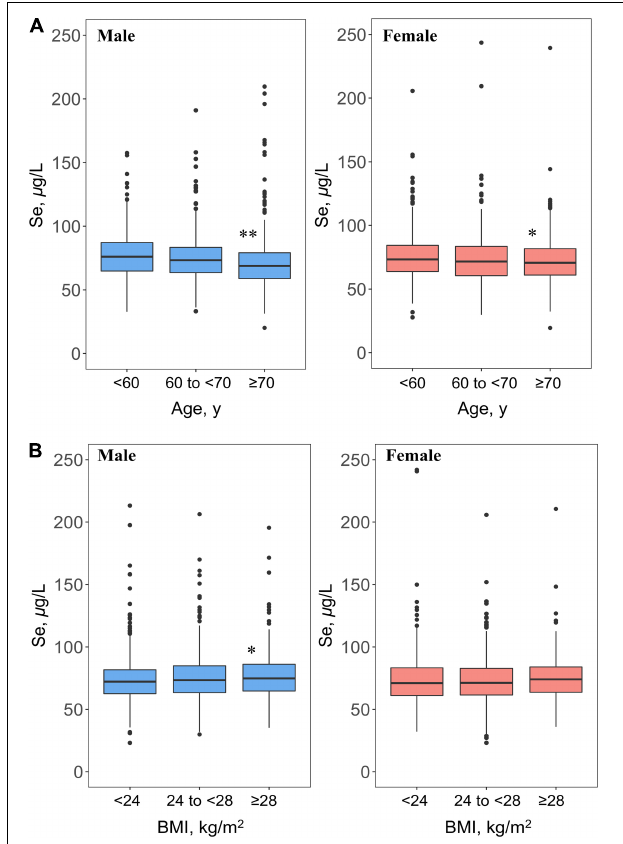
FIGURE 2 | Age (A) and BMI (B) distribution patterns of plasma Se concentrations ( µ g/L) in Chinese middle-aged and elderly adults with hypertension 1 . 1 If not stratified, plasma Se concentrations were adjusted for sex, age, region (Se-marginal, Se-sufficient, and Se-rich areas), BMI, SBP, DBP, history of hypertension, antihypertensive drug use, multivitamin use, smoking, alcohol drinking, meat consumption, and consumption of fruits and vegetables. * p < 0.05, ** p < 0.001, the average plasma Se concentration of this group significantly differed from those aged less than 60 years or with BMI less than 24 kg/m 2 among male and female